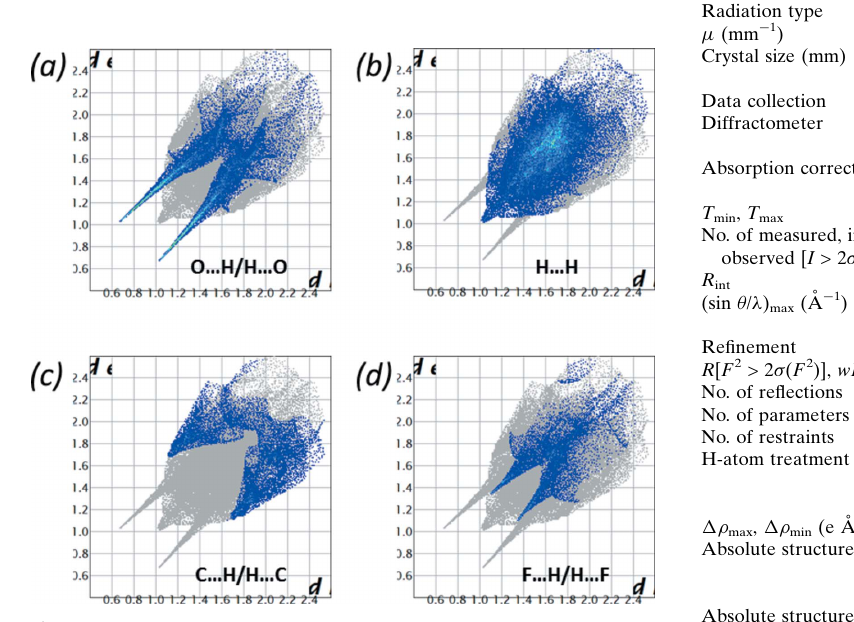
Figure 5 Two-dimensional fingerprint plots produced for the Hirshfeld surface of (I). Contributions to the plots from the O (cid:2)(cid:2)(cid:2) H, H (cid:2)(cid:2)(cid:2) H, C (cid:2)(cid:2)(cid:2) H, and F (cid:2)(cid:2)(cid:2) H contacts are shown in ( a ), ( b ), ( c ) and ( d ), respectively.